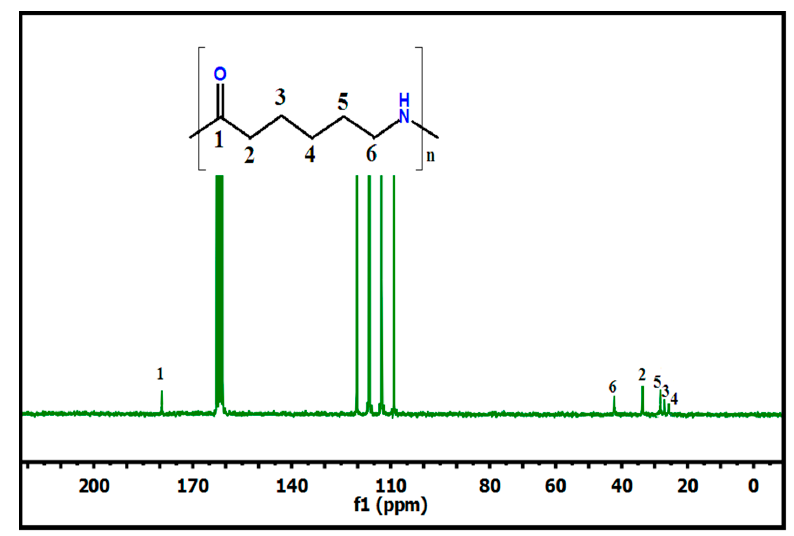
Figure 6. 13 C NMR spectrum of neat PA6 recorded in trifluoroacetic acid-d (TFAA) solvent.